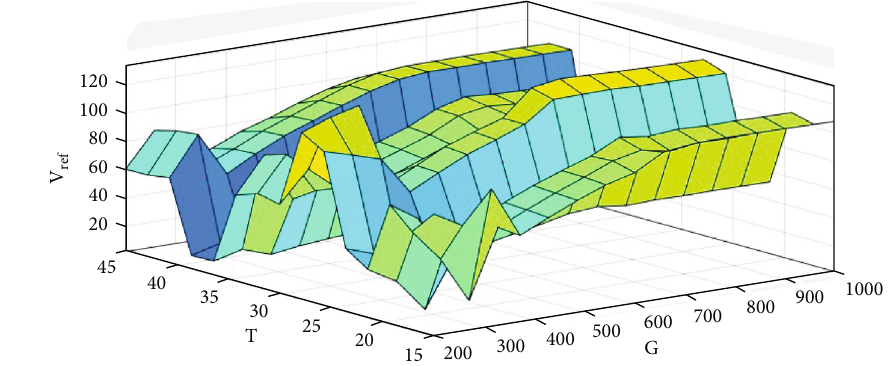
Figure 10: Rules of the ANFIS MPPT.